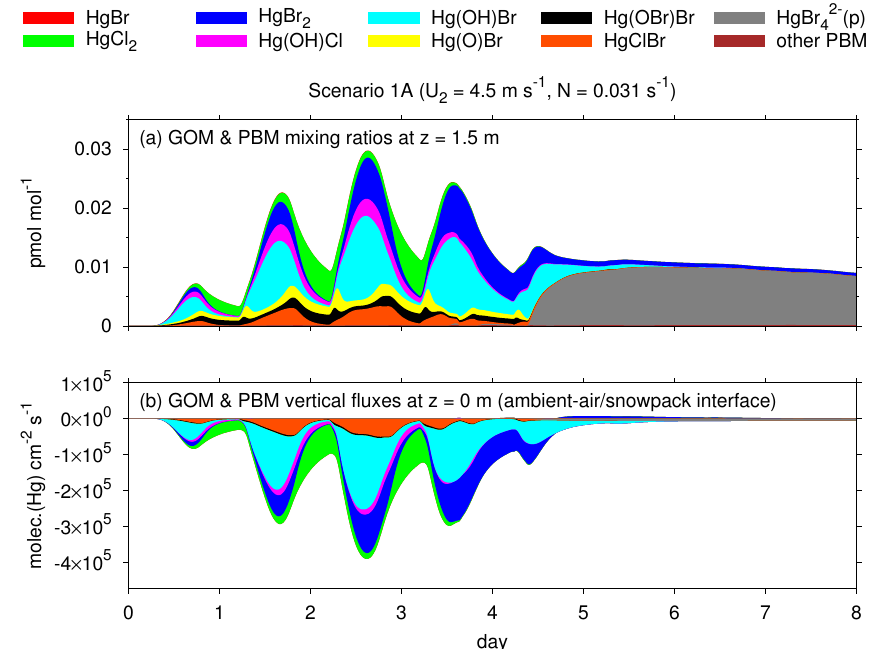
Fig. 4. Speciation and vertical fluxes of GOM and PBM as simulated with scenario 1A at U 2 = 4 . 5 ms − 1 : (a) mixing ratios of GOM and PBM species at z = 1 . 5 m in ambient air above the snowpack and (b) vertical fluxes of GOM and PBM species at z = 0 m, i.e. between ambient air and snowpack. Because of very low mixing ratios simulated, gaseous Hg(OH) 2 is neglected in these plots.